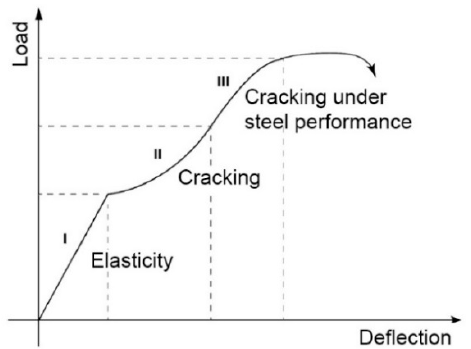
Figure 3. Typical load-deflection diagram of a reinforced concrete beam under bending. Source: [13]